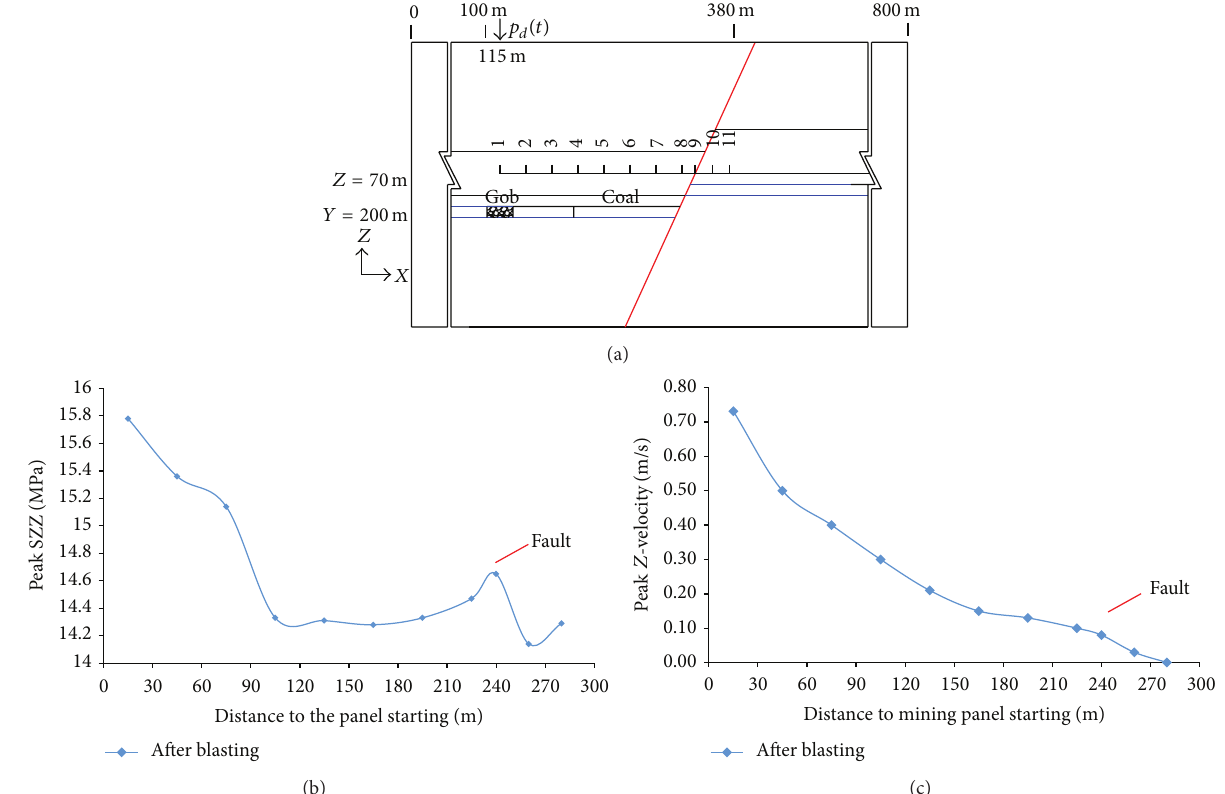
Figure 9: Vertical stress and velocity attenuating curve of stress wave ( 𝑝 𝑑𝑚 = 30 MPa, depth = 500 m): (a) monitor locations; (b) peak SZZ; and (c) peak 𝑍